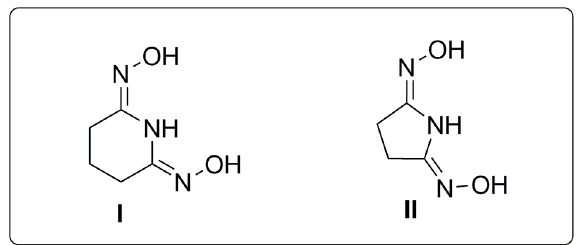
Figure 1. Basic cyclic imide dioxime scaffolds.